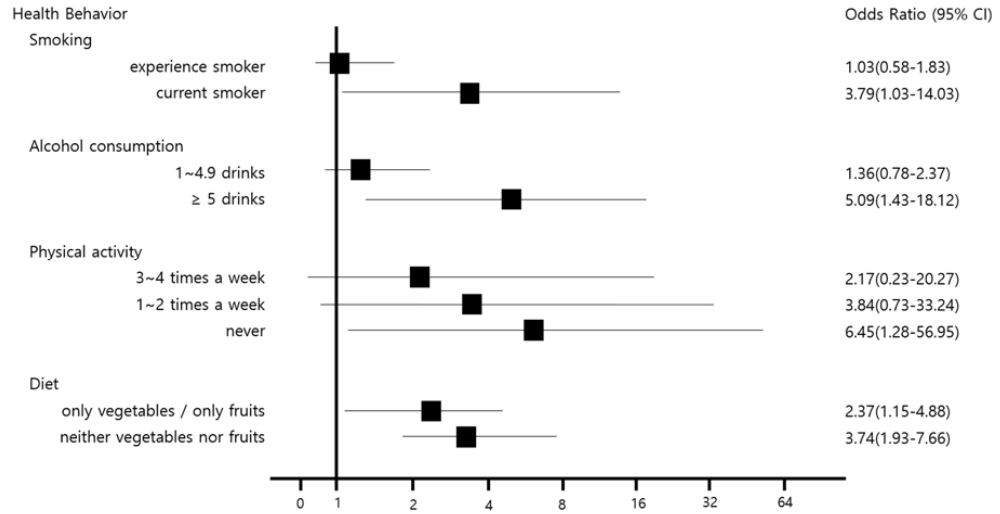
Figure 1. Odds ratio (OR) of health behaviors including smoking, alcohol consumption, physical activity, and diet. The OR was marked to the square points, and adjusted for working years, marital status, waist circumference, systolic blood pressure, and diastolic blood pressure. References were “Never” on smoking, “None or <1 drink” on alcohol consumption, “5~6 times a week” on physical activity, and “Both vegetables and fruits” on diet. CI = confidence interval.